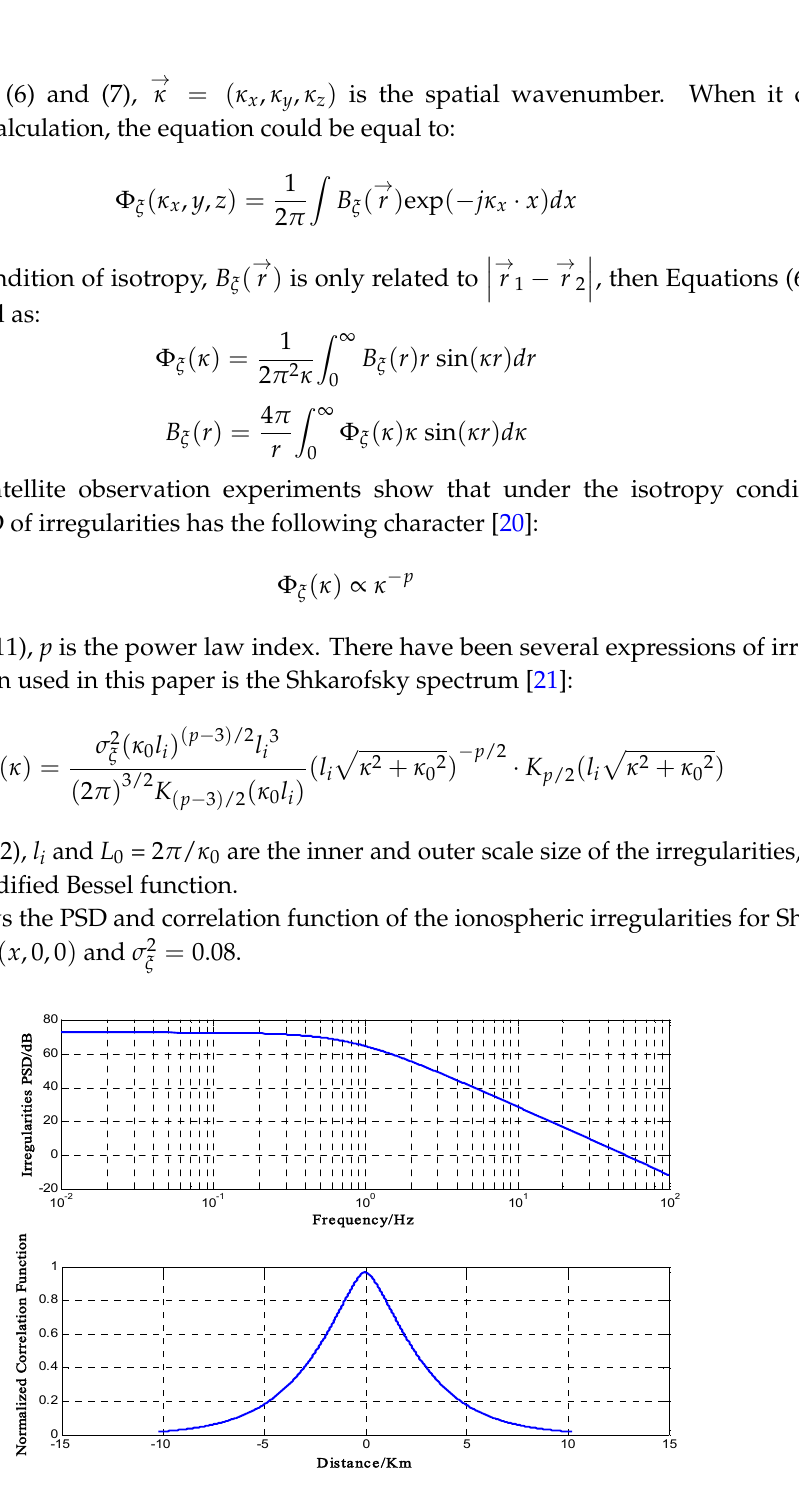
Figure 1. ( top ) PSD and ( bottom ) correlation function of irregularities in the ionosphere.